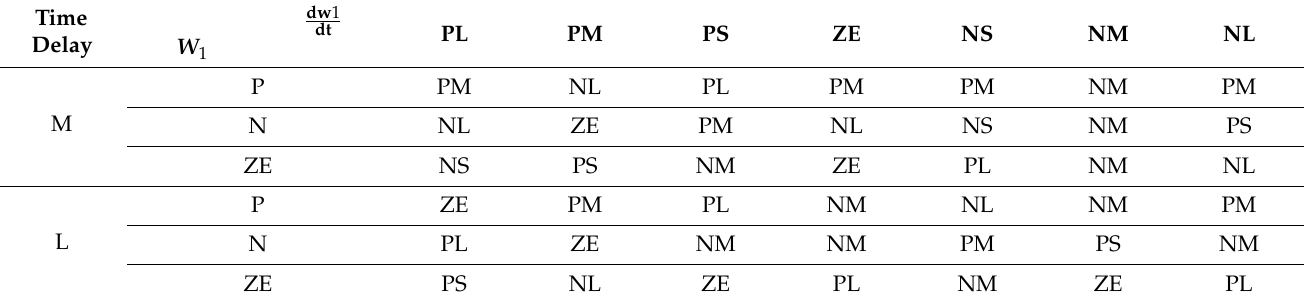
Table 3. Rule based on wide-area fuzzy controller with time delay.